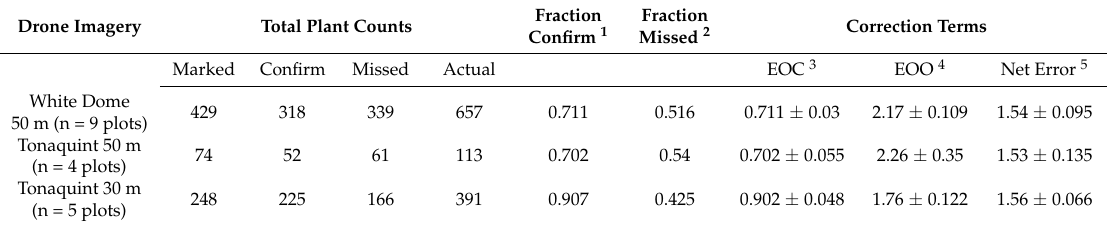
Table 1. Validation data matrix for drone imagery obtained over plots at 50-m altitude at White Dome, at 50-m altitude at Tonaquint, and at 30-m altitude at Tonaquint. Putative poppy plants were marked on high-altitude imagery, then confirmed on validation imagery at 15 m. Additional plants found on 15-m imagery but not on the higher altitude imagery were scored as missed. Error terms are standard error of the mean of plot values. (See Supplemental File S2 for full validation data